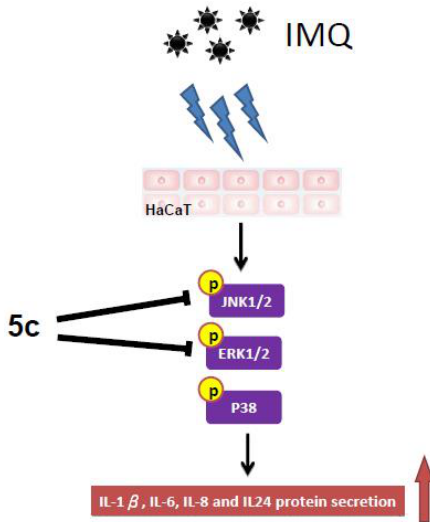
Figure 6. The supposition of mitogen-activated protein kinases (MAPKs) regulated proinflammatory pathways in psoriasis. pathways in